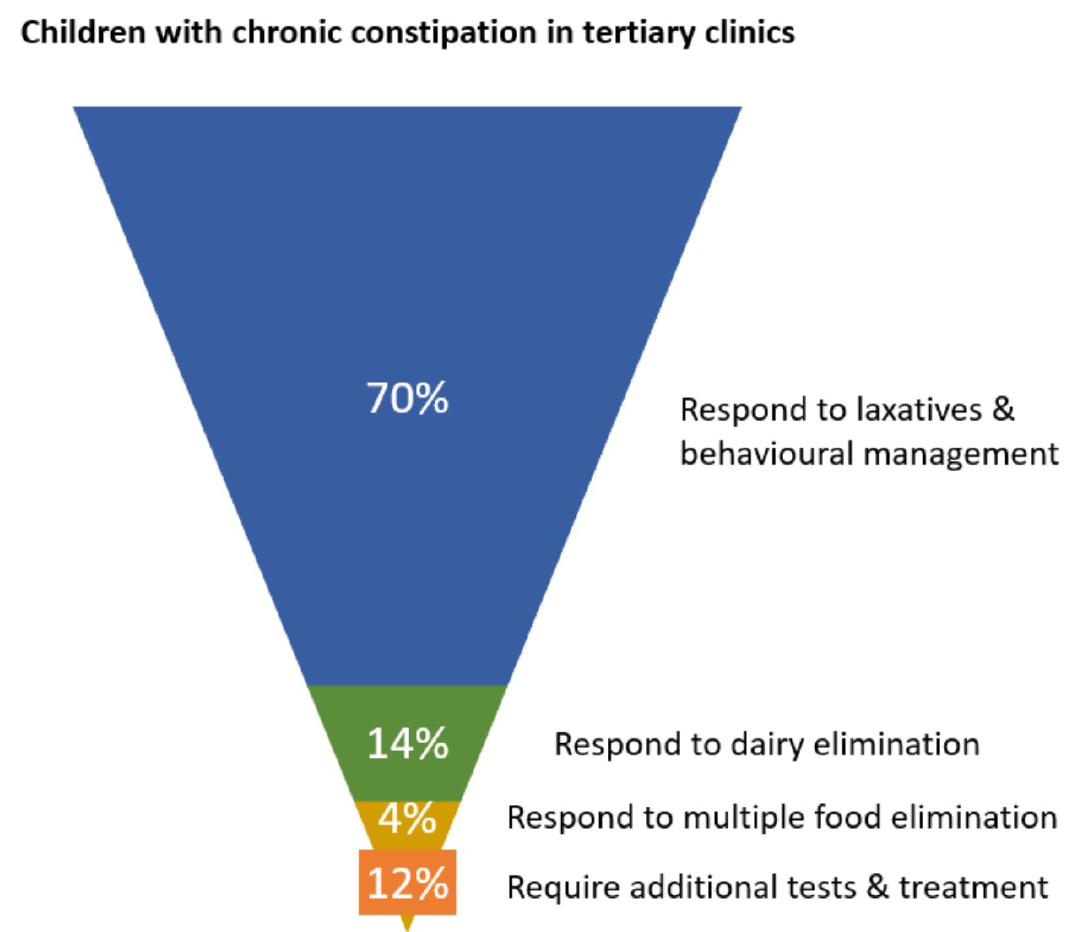
Figure 2. Schematic showing proportions of children in tertiary clinics responding to initial phases of management for chronic